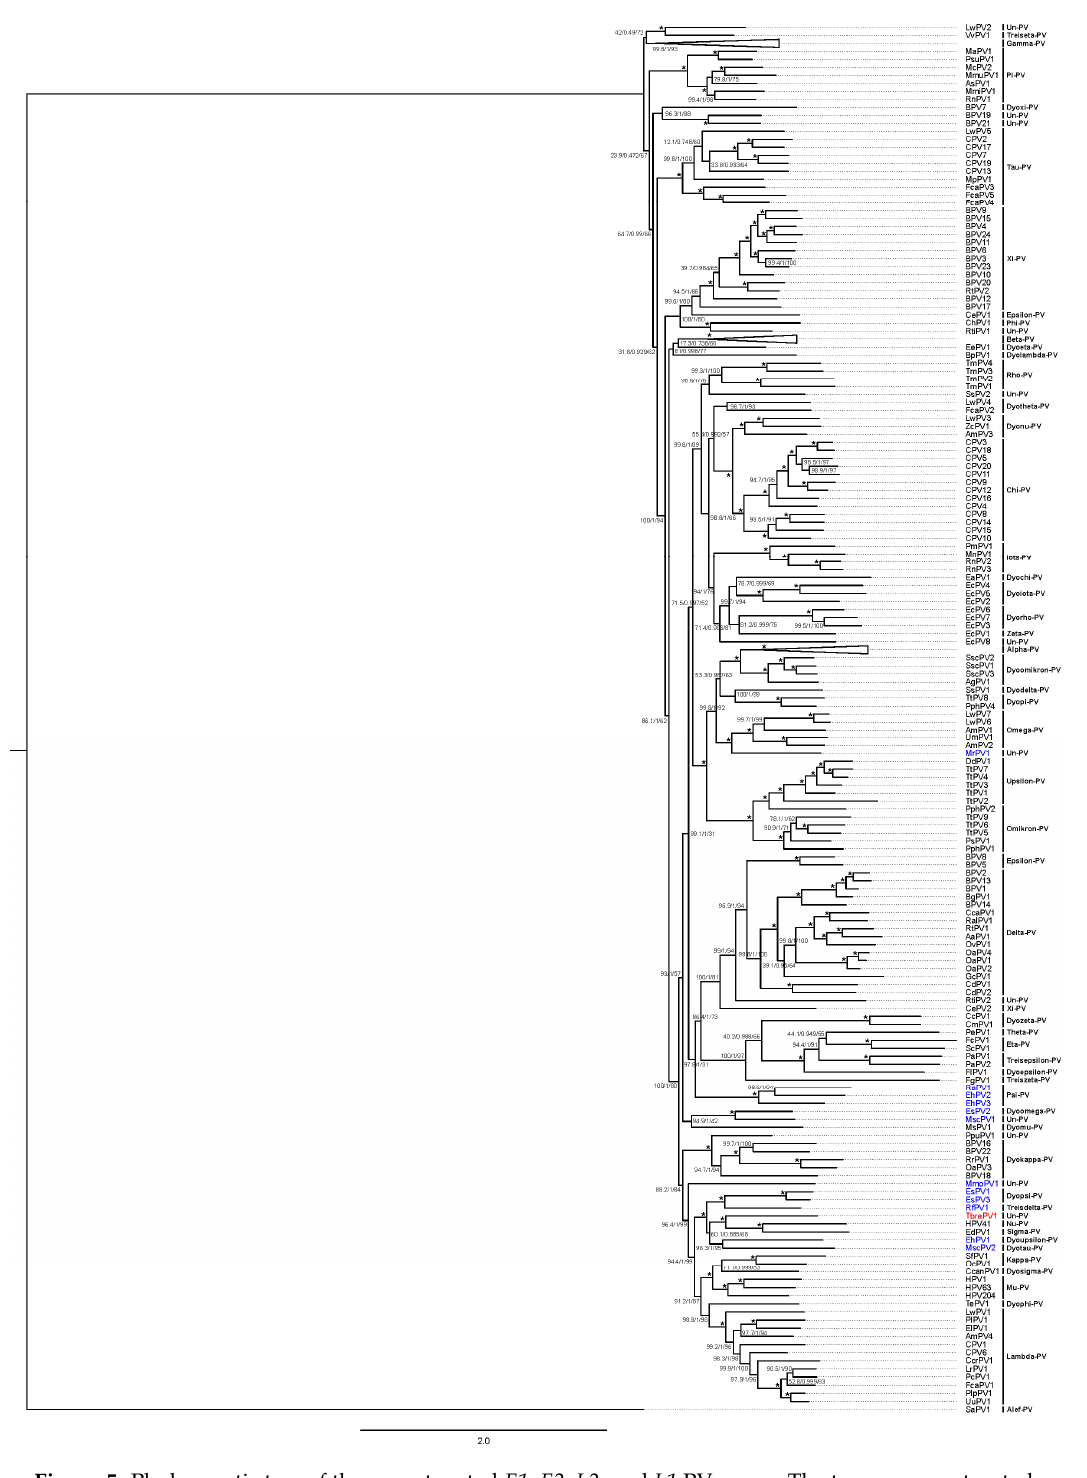
Figure 5. Phylogenetic tree of the concatenated E1, E2, L2 , and L1 PV genes. The tree was constructed using the GTR + F + G4 model, and branches are annotated with Sh-aLRT (1000 replicates), aBayes, and UF bootstrap support (1000 replicates) values, respectively. Maximum support values are shown with asterisks (*). Alpha- , Beta- , and Gamma-PV genera were collapsed. Novel TbraPV1 is depicted in red. Bat PV types are depicted in blue. Un-PV: unclassified PV